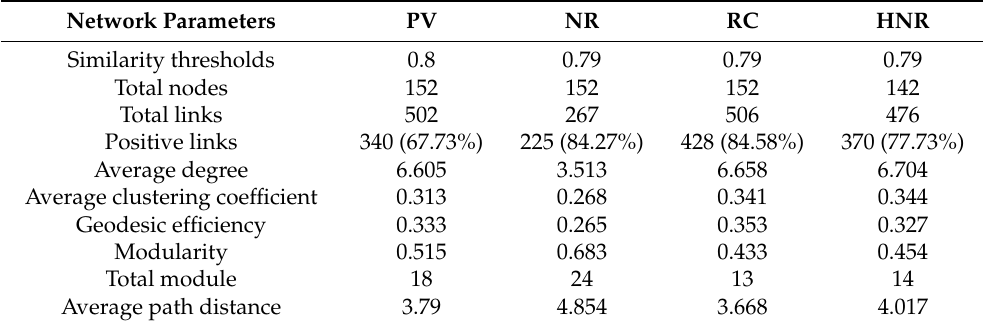
Table 2. Comparison of the topological properties of microbial molecular ecological networks in the study